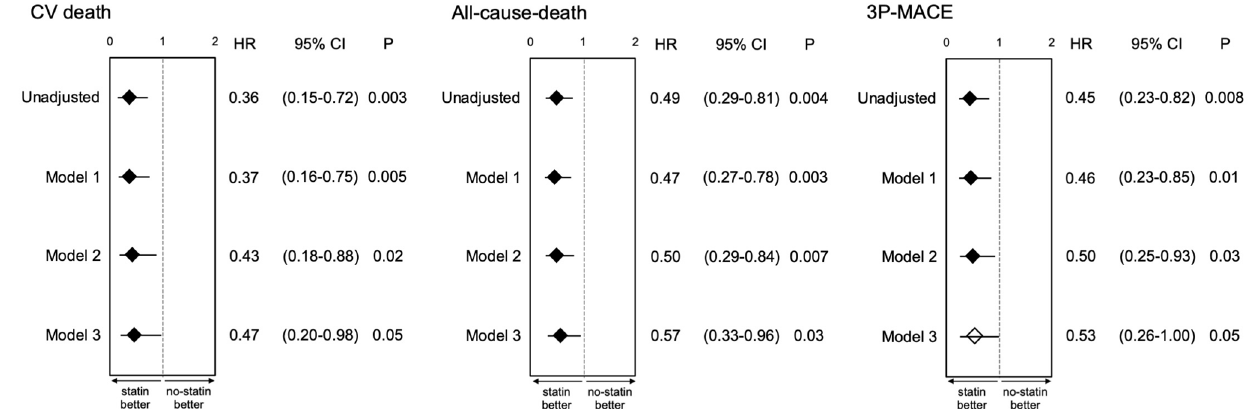
Figure 3. Hazard ratios of statins for cardiovascular events in hemodialysis patients following PCI. Hazard ratios of statin therapy at PCI for unadjusted and adjusted by 3 models. Closed and open rhombuses indicate significant ( p < 0.05) and insignificant ( ≥ 0.05) association of statin therapy with endpoints, respectively.